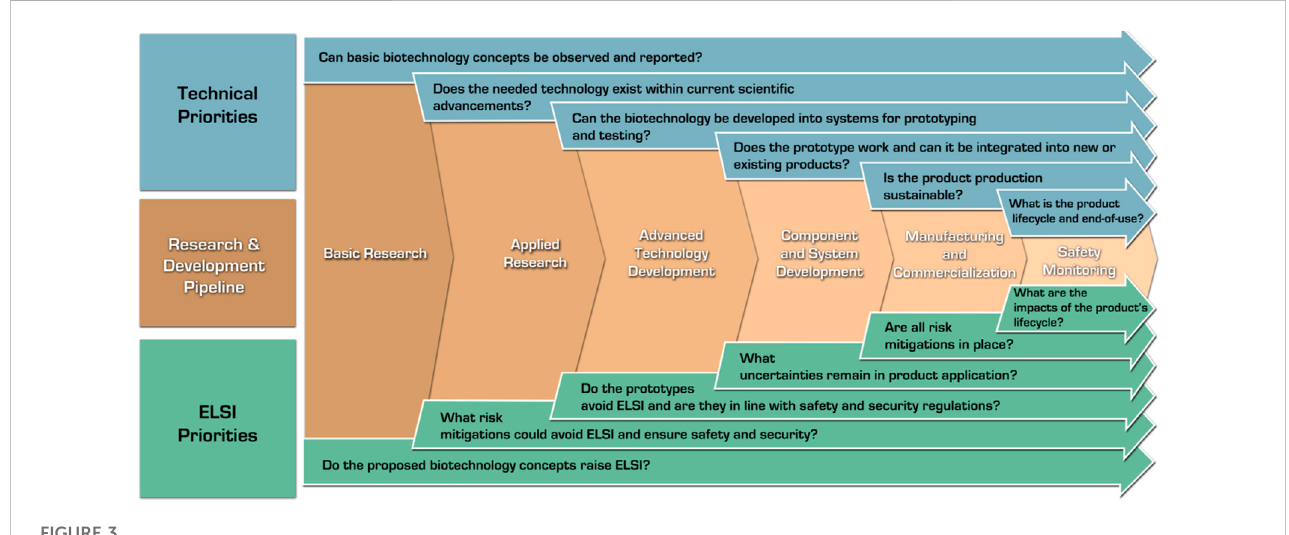
FIGURE 3 Safety-by-design in the research and development pipeline: ELSI and technical